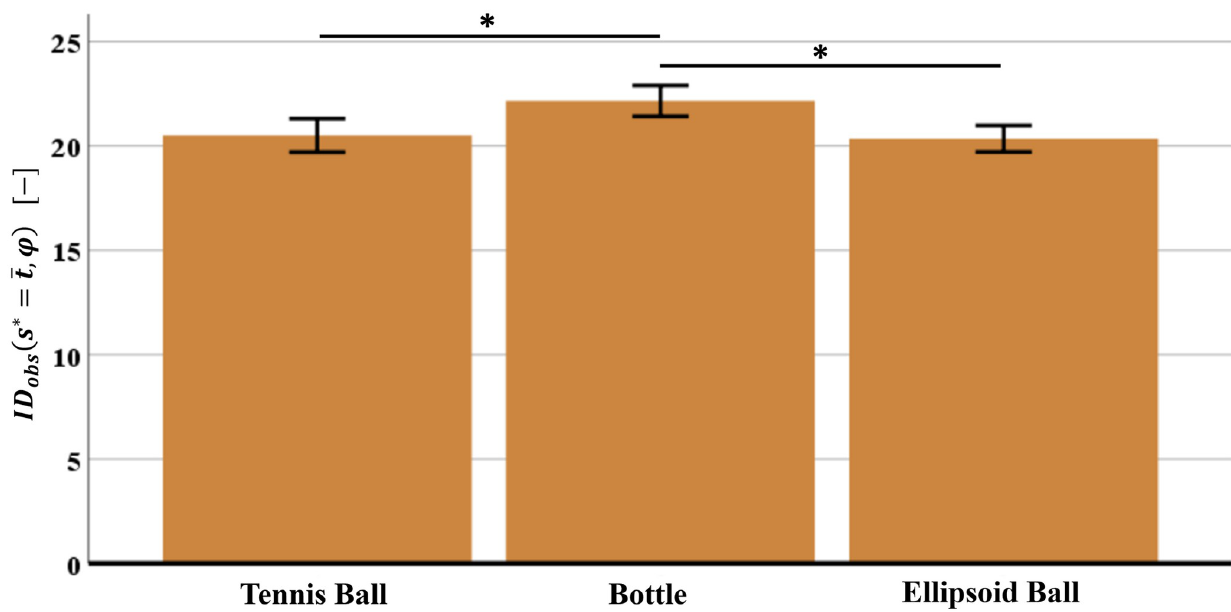
(cid:0) � evaluated for the entire manipulation s � ¼ � t � ; φ obs